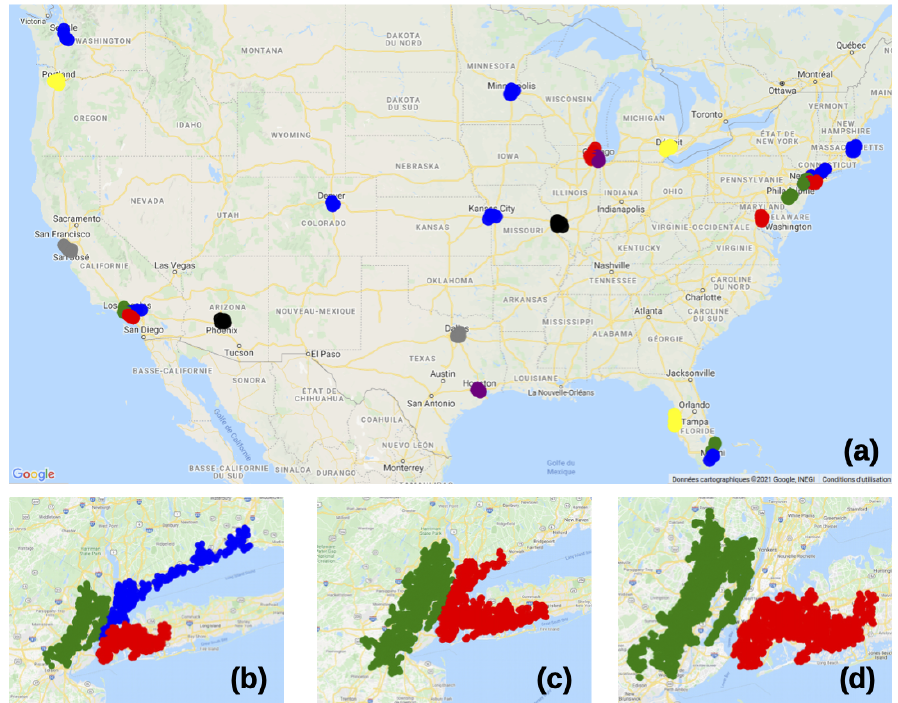
Figure 3. Results obtained using the greedy CORE-clustering algorithm on the U.S. road network ( ≈ 2.4 × 10 7 nodes) in about one minute. ( a , b ) CORE-clusters obtained using τ = 5 × 10 4 and ξ = 10 − 3 represented in the U.S. and in New York City urban area. ( c ) CORE-clusters obtained using τ = 1 × 10 5 and ξ = 10 − 3 represented in New York City urban area only. ( d ) CORE-clusters obtained using τ = 5 × 10 4 and ξ = 0.5 represented in New York City urban area only. Background: Google maps . Clusters represented using MI Map Tools: GeoPlotter